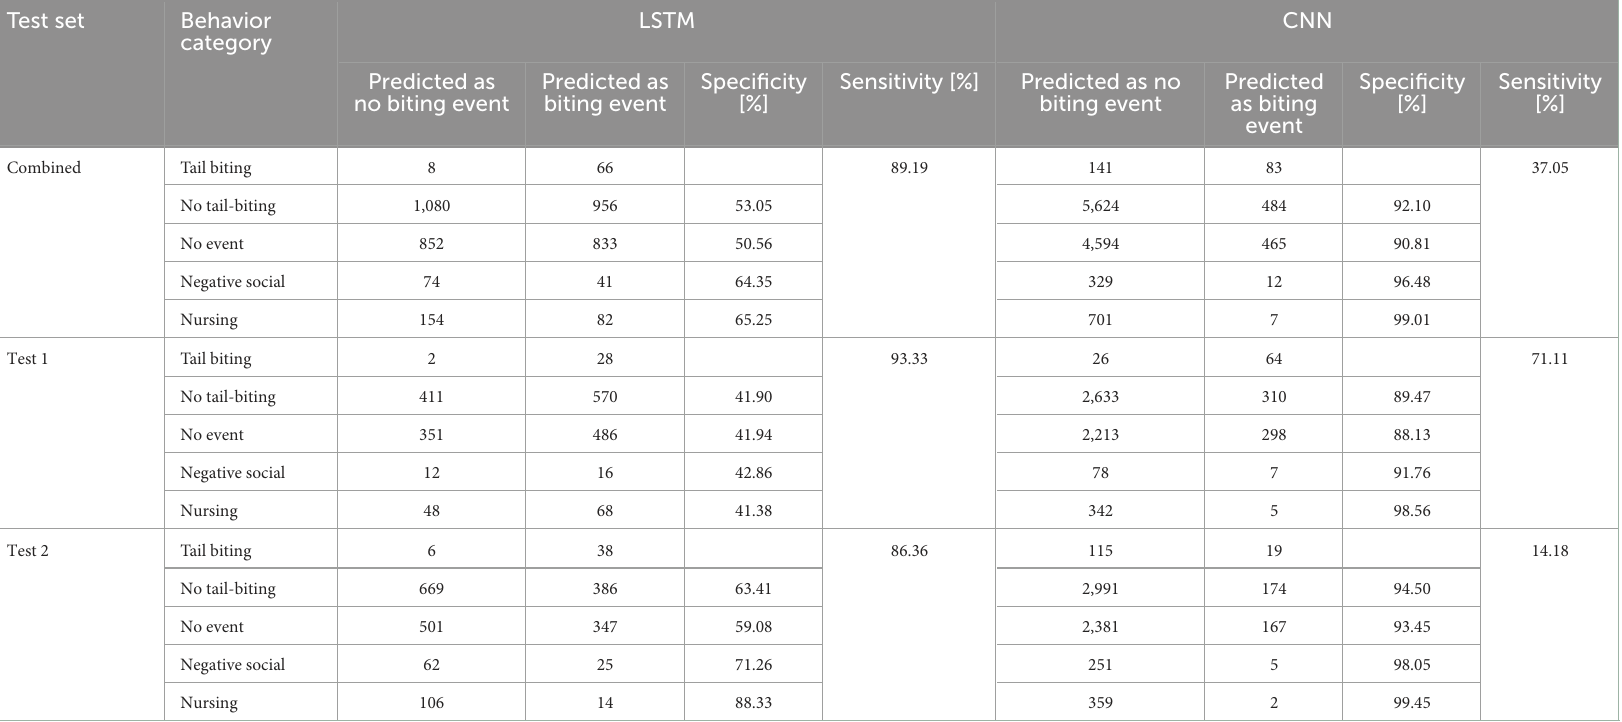
TABLE 9 Predicted behavioral categories and corresponding specificity of the test sets for the LSTM and CNN